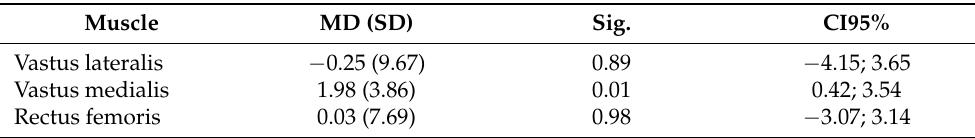
Table 3. Mean differences (standard deviations) of and changes in physical measurements evaluated in both assessments in median